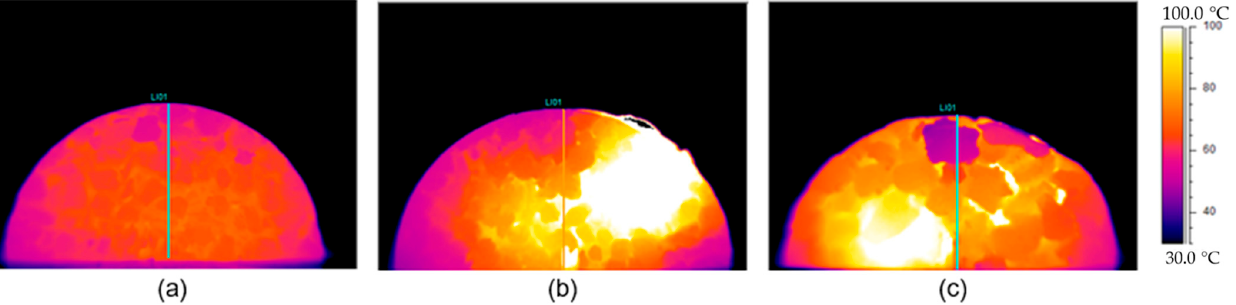
Figure 5. The SCB specimens with different mixture types after microwave heating: ( a ) PA1, ( b ) PA2, and ( c ) PA3.